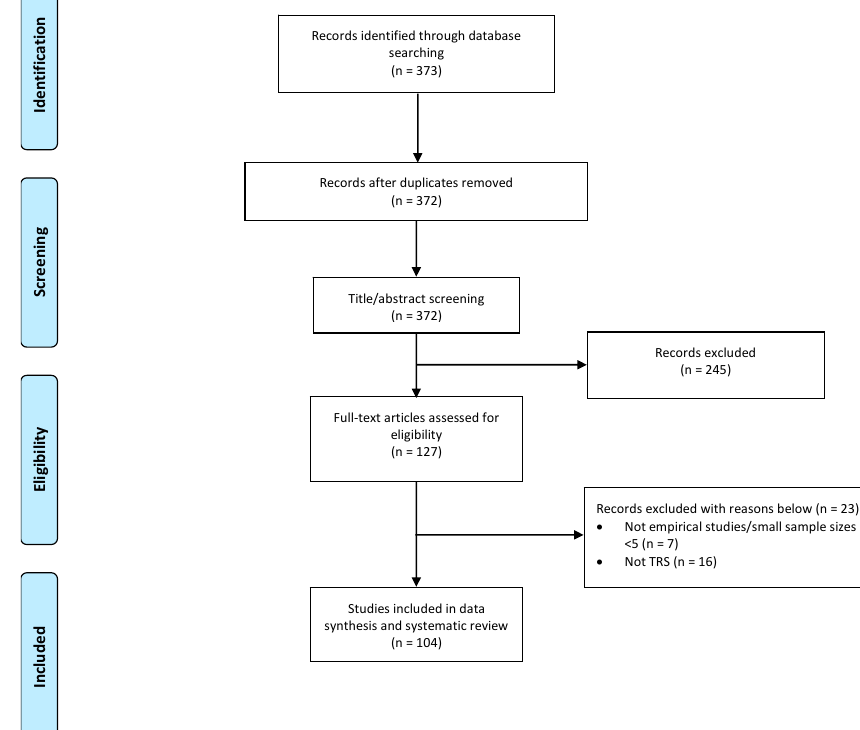
Figure 1. PRISMA chart of studies included in this review